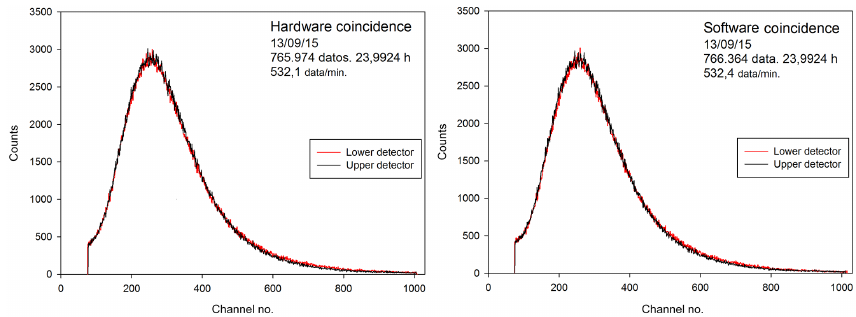
Figure 14. Comparative tests between data acquired with hardware (left panel) and software (right panel) coincidence by the muon tele- scope (MD1). Black and red lines correspond to the histogram of upper and lower detectors,